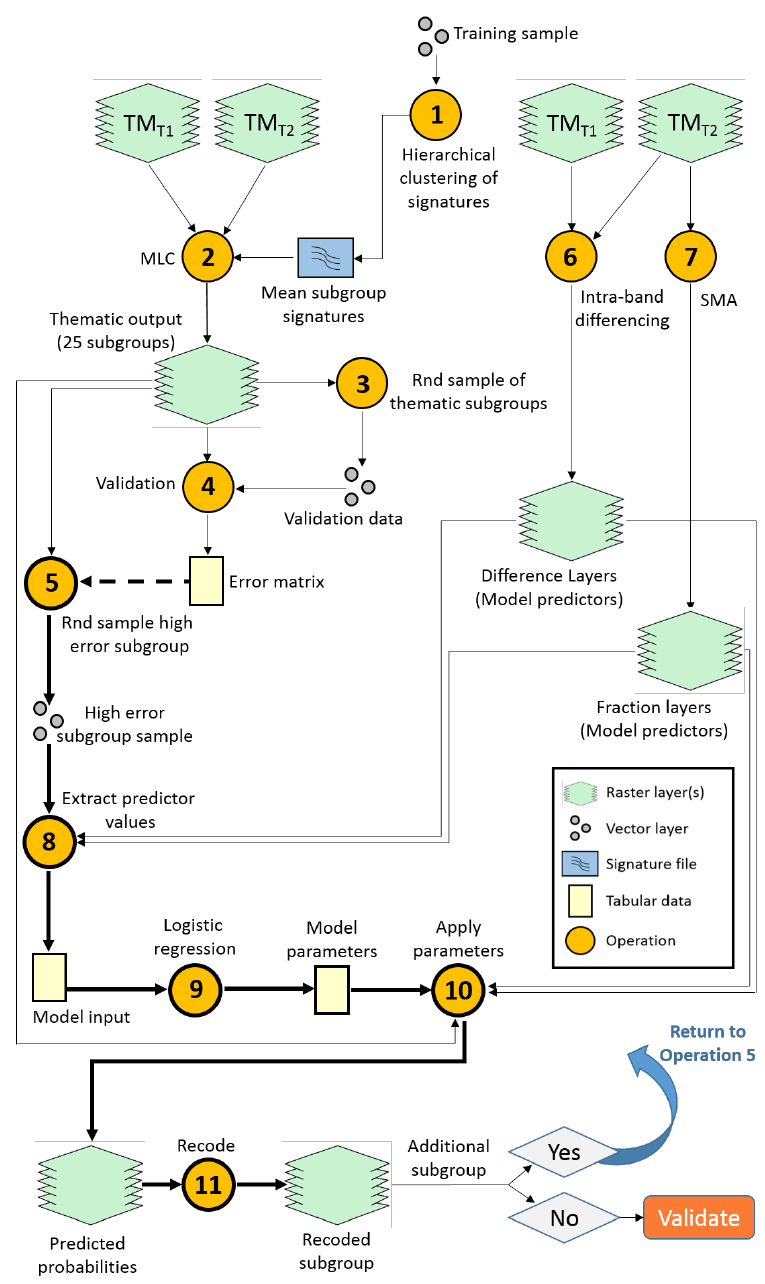
Figure 2. Classification workflow using objects and syntax analogous to the model builder in ERDAS Imagine. Note that reclassification iterations are performed by repeating the loop of Operations 5, 8–11 (in bold), the remaining operations are performed once. The dashed line, directing to Operation 5 in the diagram, represents data not used directly in the operation but rather to establish parameters for Operation